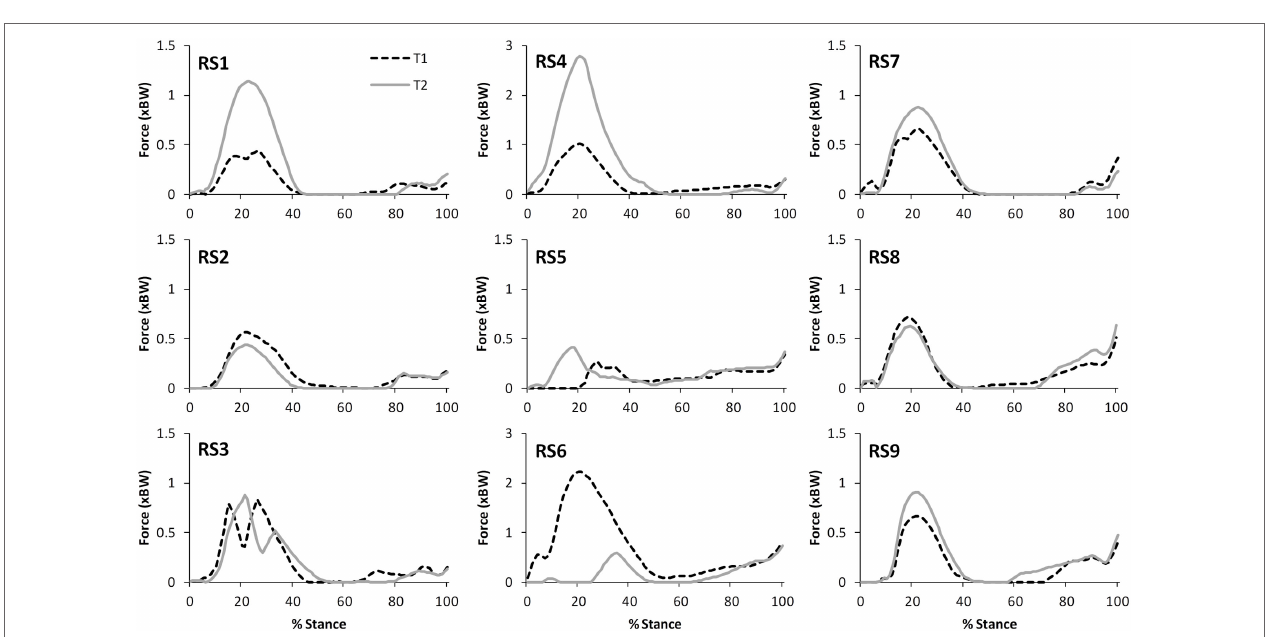
FIGURE 5 | A comparison of the subject specific variation (between test sessions 1 and 2) in predictions of patellofemoral joint contact forces during gait.